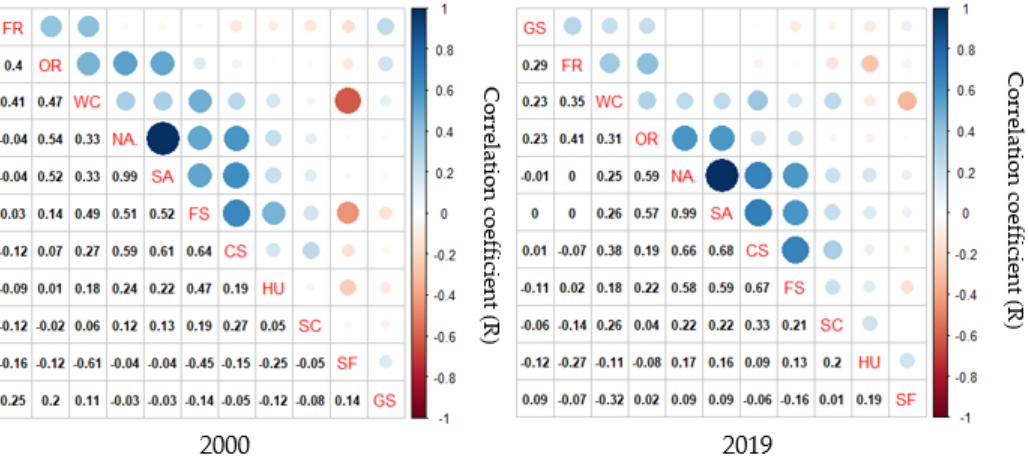
Figure 3. Correlation map of ES in Shenyang during 2000 and 2019, food supply (FS), grass supply (GS), water conservation (WC), carbon sequestration (CS), SO2 absorption (SA), NOx absorption (NA), humidification (HU), soil conservation (SC), flood regulation (FR), soil fixation (SF), outdoor recreation (OR). The blue and red circle indicate positive and negative correlations, respectively.